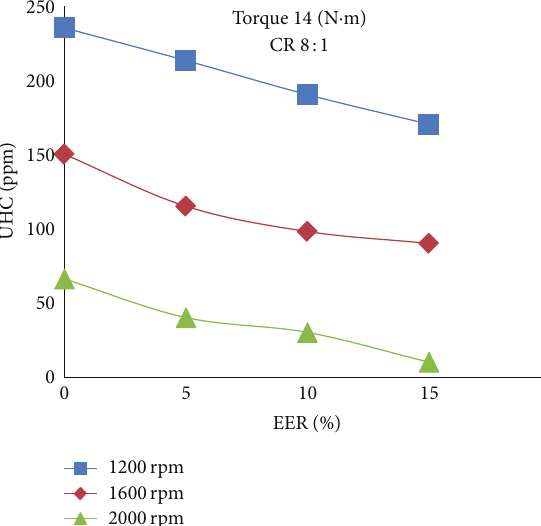
Figure 6: Effect of speed on CO 2 concentration.